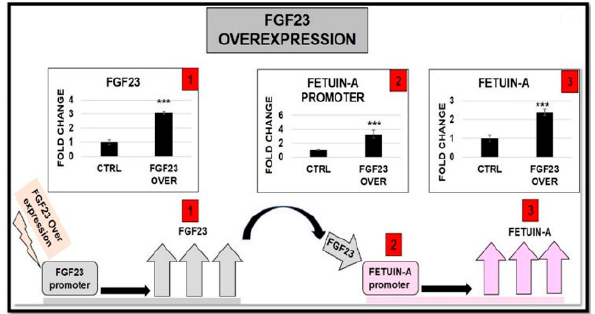
Figure 10. qRT-PCR of FGF23 (1), Fetuin-A promoter (2), and Fetuin-A 24 h (3) after FGF23 overexpression: *** p < 0.001.